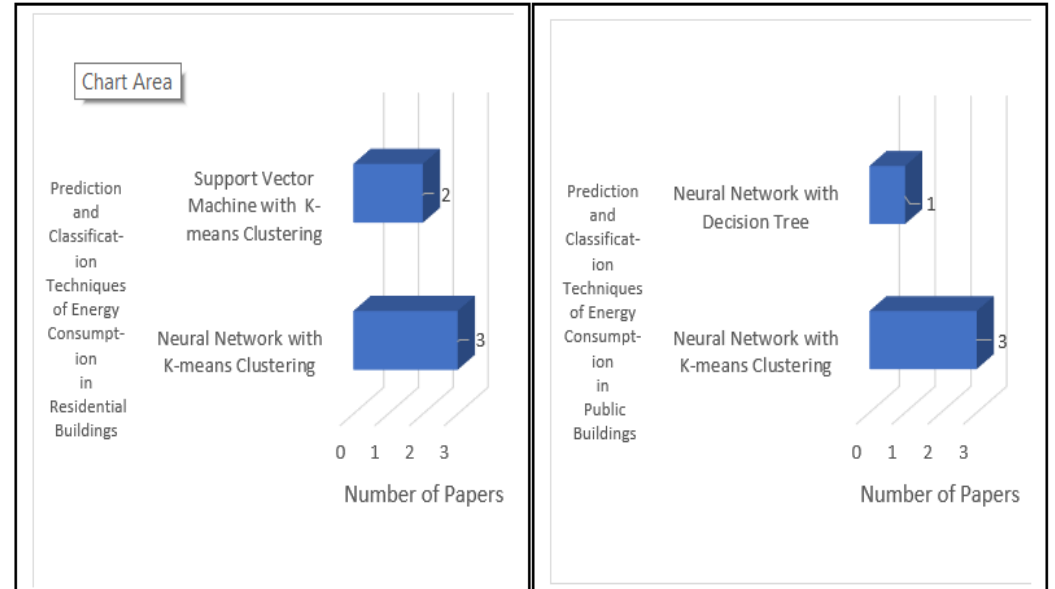
Figure 11. Prediction and classification techniques that used energy consumption in residential and public buildings.